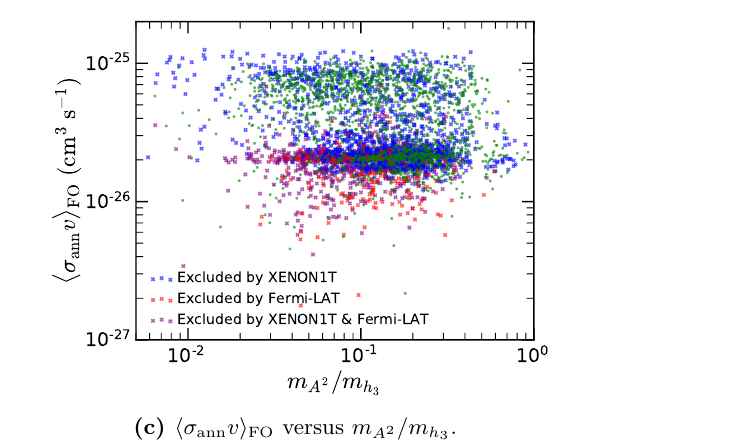
Figure 2. Freeze-out effective annihilation cross section h σ ann v i FO versus m m /m h (b), and m A 2 2